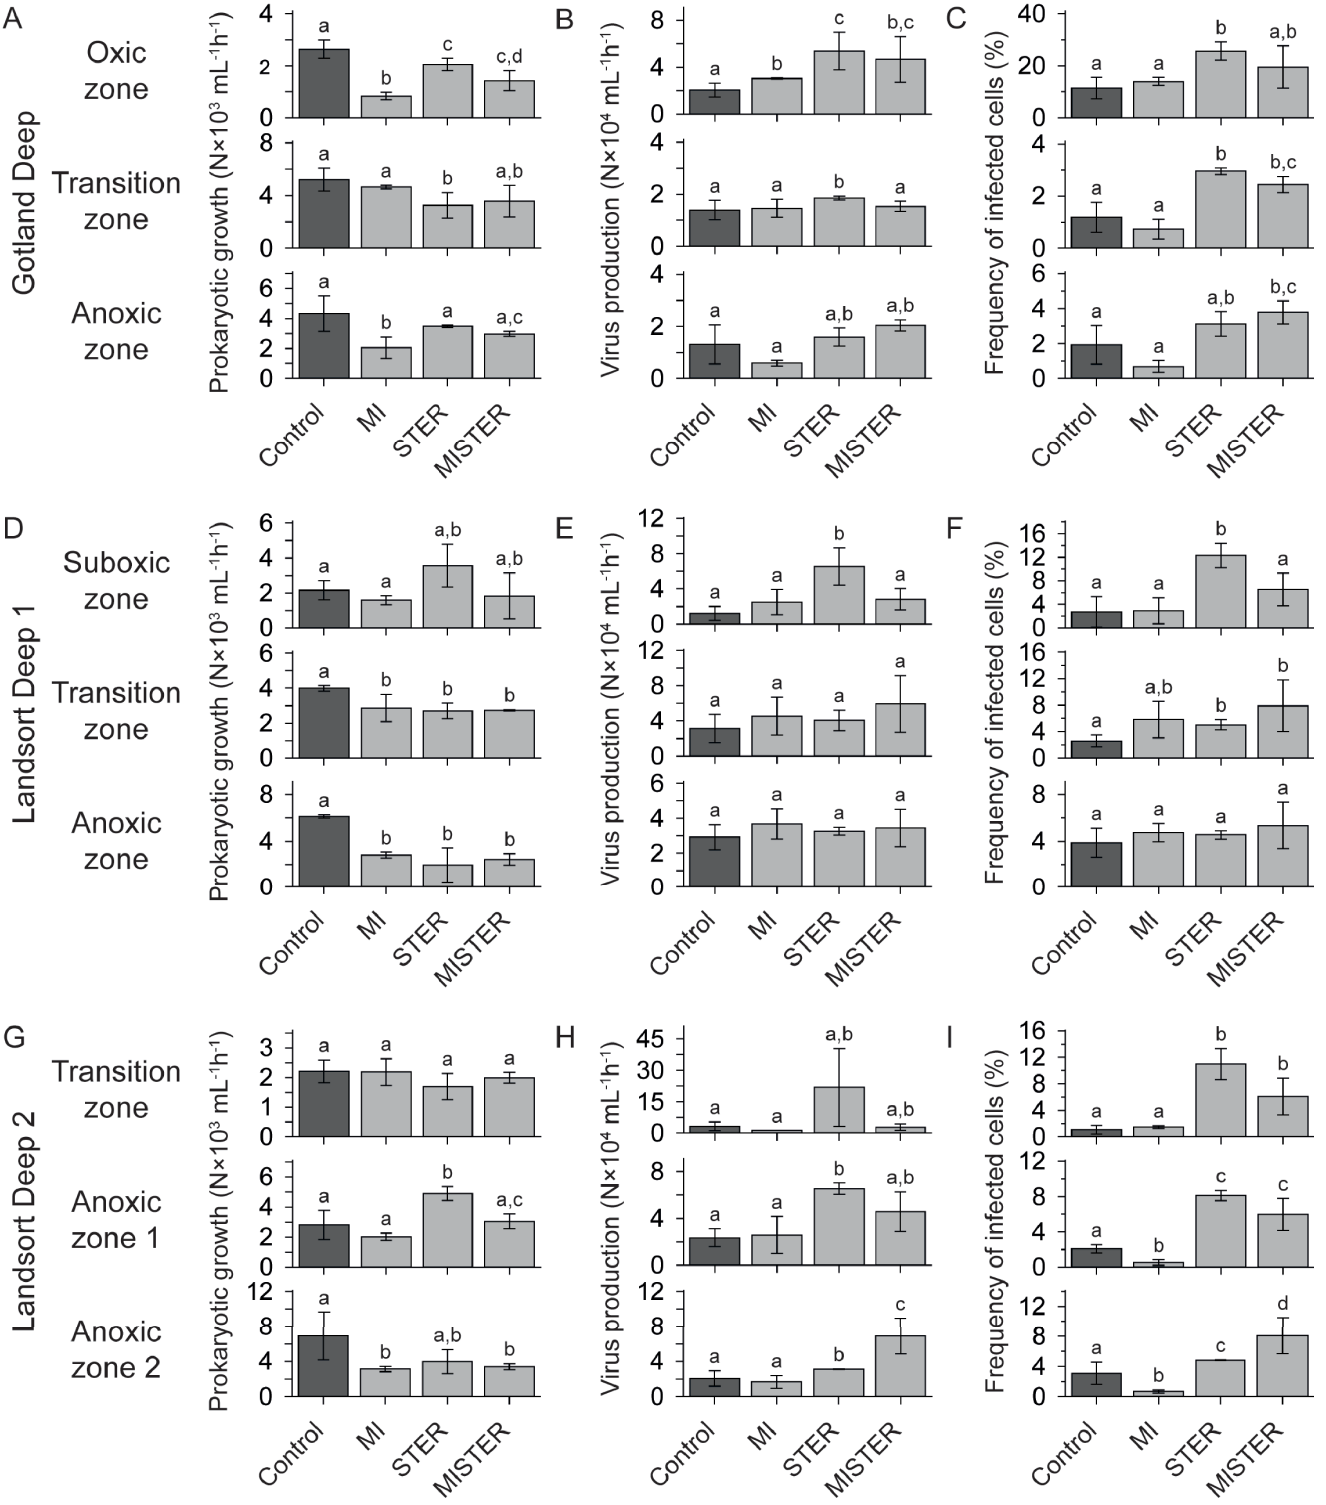
Fig 1. Treatment effects on prokaryotic growth (PG), viral production (VP) and the frequency of infected cells (FIC). The figure shows average values of duplicate incubations for PG (A, D, G), VP (B, E, H), and FIC (C, F, I) in controls and experimental treatments (MI: mitomycin C; STER: streptomycin and